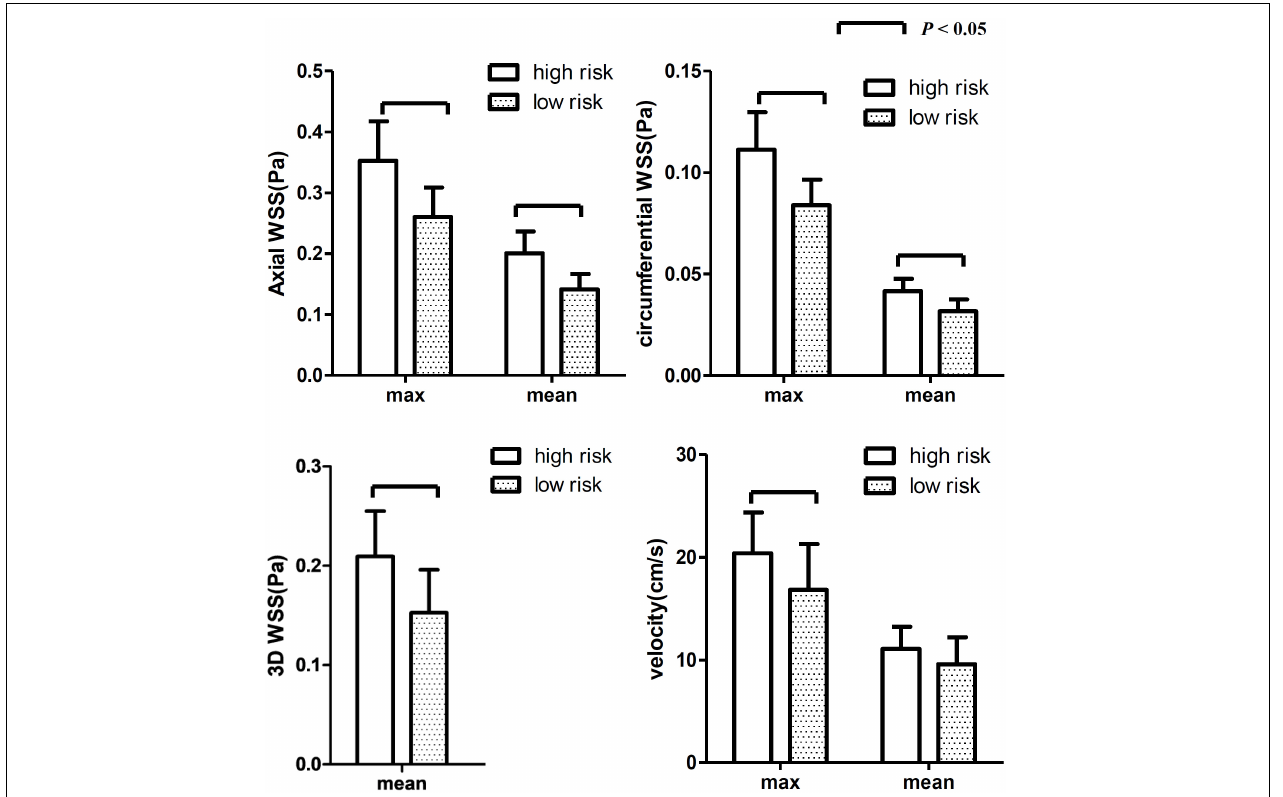
FIGURE 4 | The differences in WSS (axial, circumferential, and 3D) and velocity at all 20 time points. The WSS values were higher in the high-risk group than those in the low-risk group. Both max and mean WSS values between the two groups were found significant, while no significant difference was found for mean velocity.